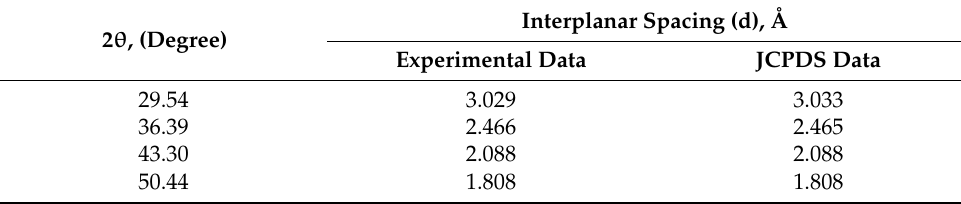
Table 1. Comparison of experimentally determined interplanar spacings with JCPDS data. Interplanar Spacing (d), Å 2 θ , (Degree) Experimental Data JCPDS Data